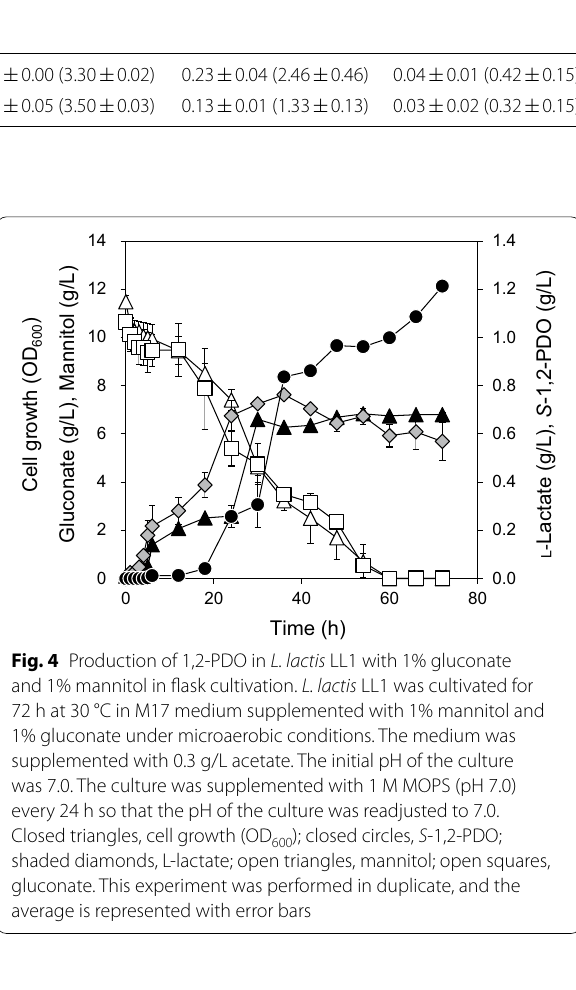
Table 2 Production profiles of metabolites in the engineered L. lactis after 72 h of cultivation with 1% glucose Strains